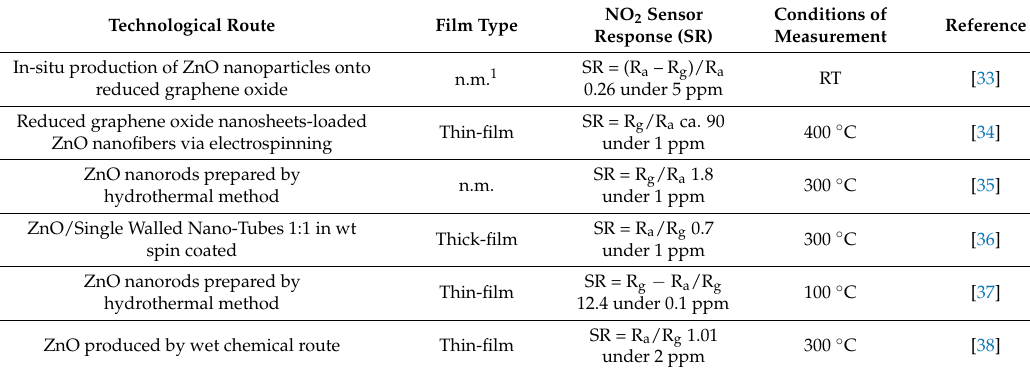
Table 4. Response towards NO 2 of ZnO-based resistive